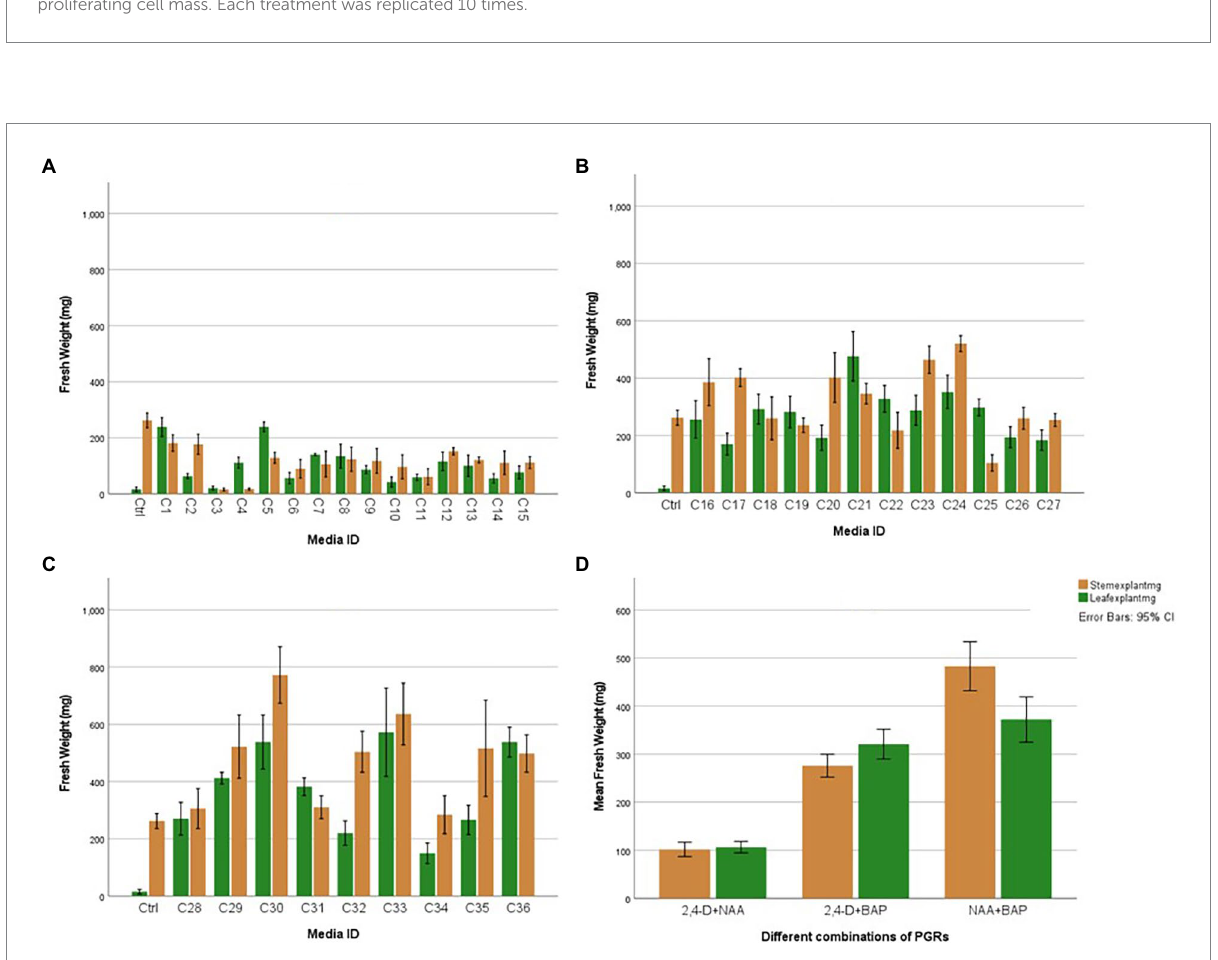
FIGURE 6 Average fresh weight of leaf and stem explants after 45 days with individual and different combinations of 2,4-D (2,4-Dichlorophenoxyacetic acid), NAA (1-Naphthaleneacetic acid), and BAP (6-Benzylaminopurine): (A) Effect of 2,4-D (2,4-Dichlorophenoxyacetic acid) and NAA (1-Naphthaleneacetic acid), (B) Effect of 2,4-D (2,4-Dichlorophenoxyacetic acid) and BAP (6-Benzylaminopurine), (C) Effect of NAA (1-Naphthaleneacetic acid) and BAP (6-Benzylaminopurine), (D) Overall Explant response. Each treatment was replicated 10